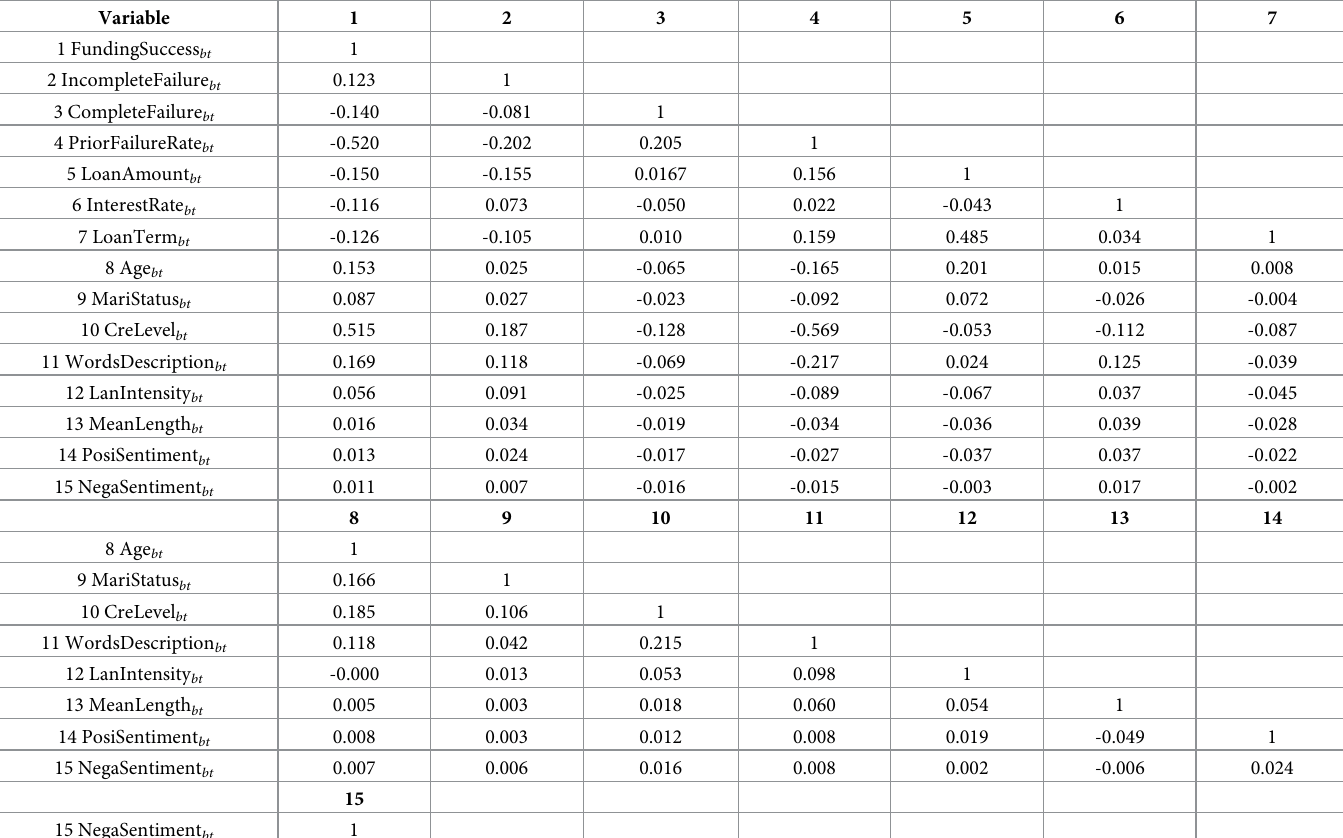
Table 4. Pearson correlations between all